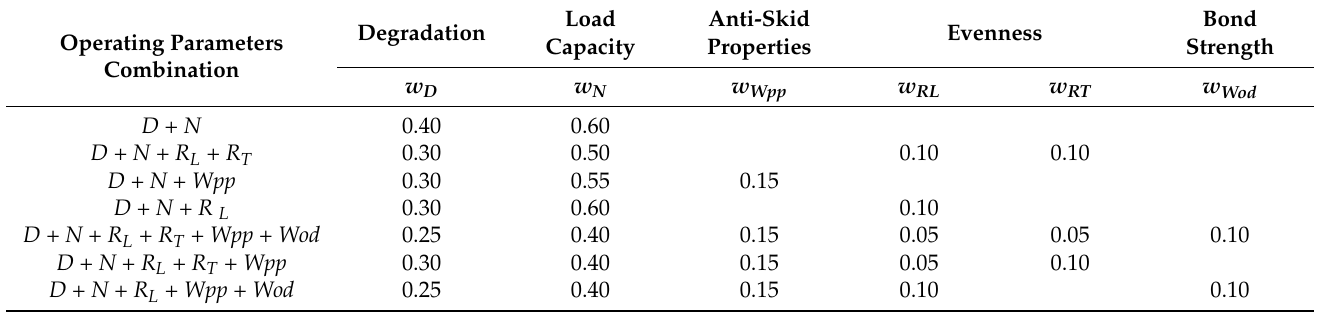
Table 2. Weights for various combinations of operating parameters of the airfield’s functional element pavement for calculating the